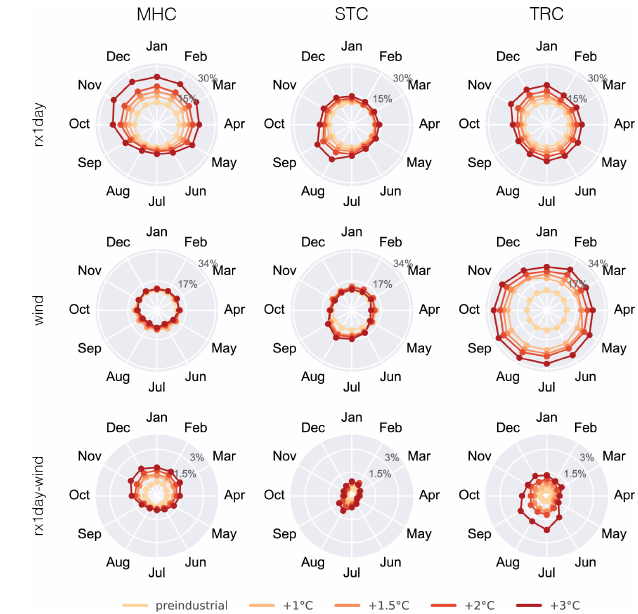
Figure 5. Same as Fig. 3 but for Rx1day, wind and concurrent Rx1day–wind